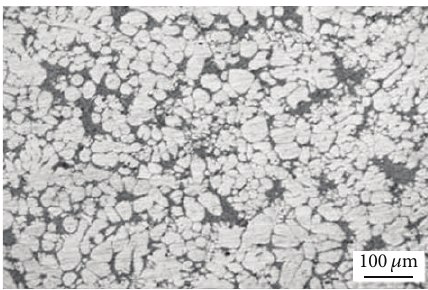
Figure 23: Microstructure of 356 aluminum alloy obtained by the GISS method